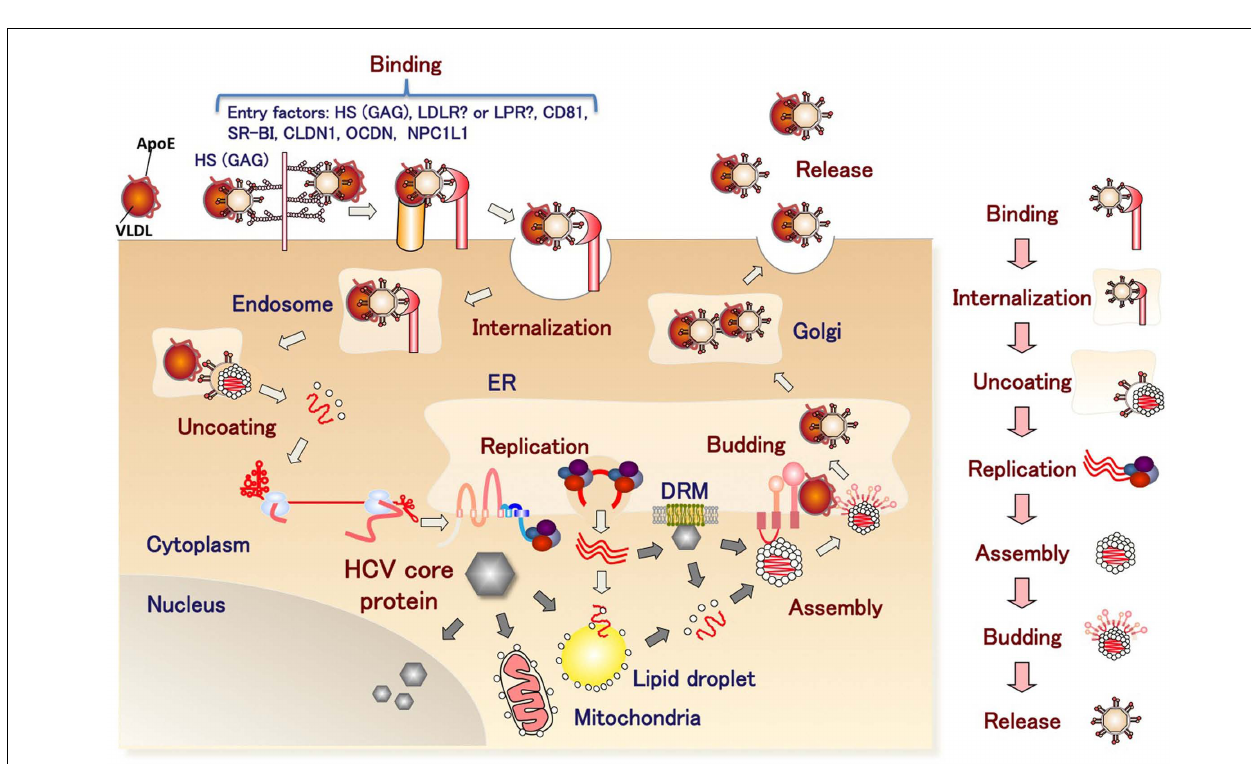
membrane structure called the membranous web.The viral nucleocapsid egresses into the lumen side of the ER and binds toVLDL.The HCV complex withVLDL is released from the infected